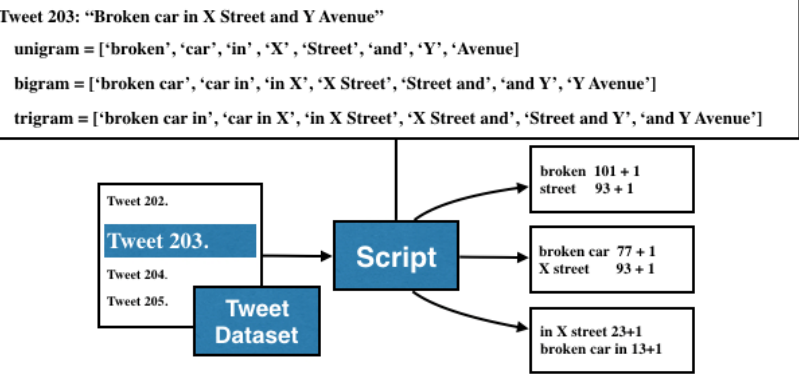
Figure 2. Computing of the lists with most frequent N ‐ grams by the script.